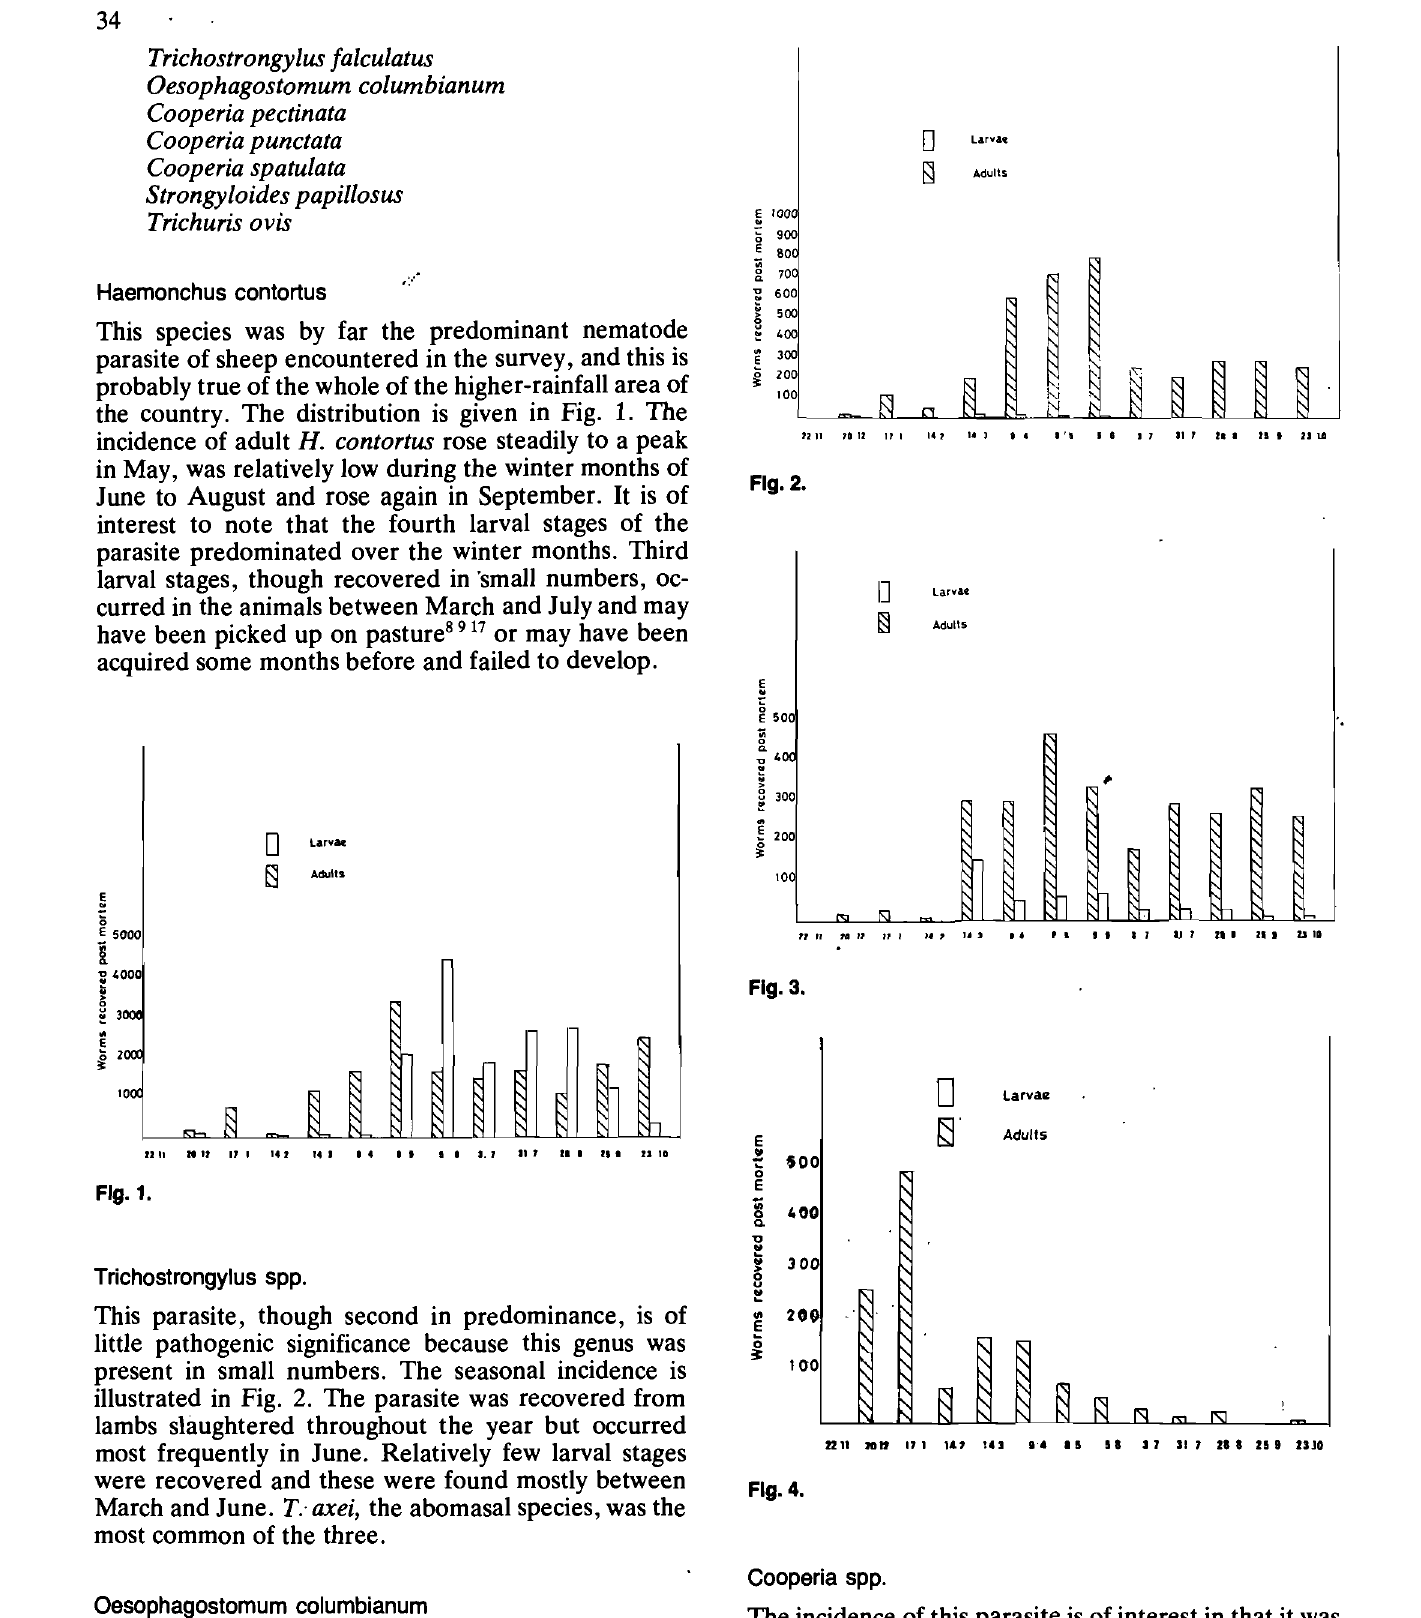
Trichostrongylus